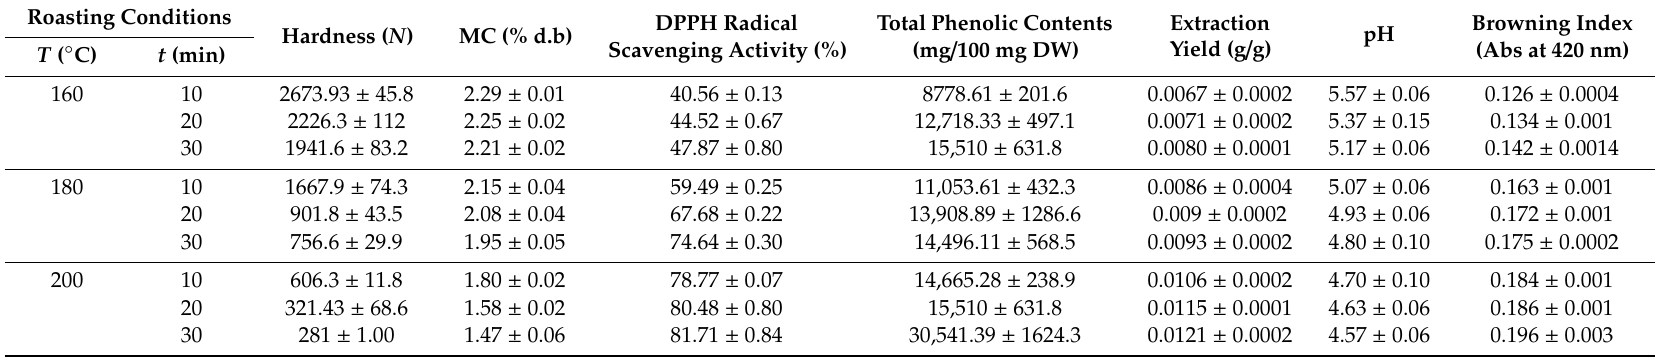
Table 2. Means and standard deviations of the physical, antioxidative and quality properties of the whole date seeds, powder and brew as a function of roasting temperature and time.